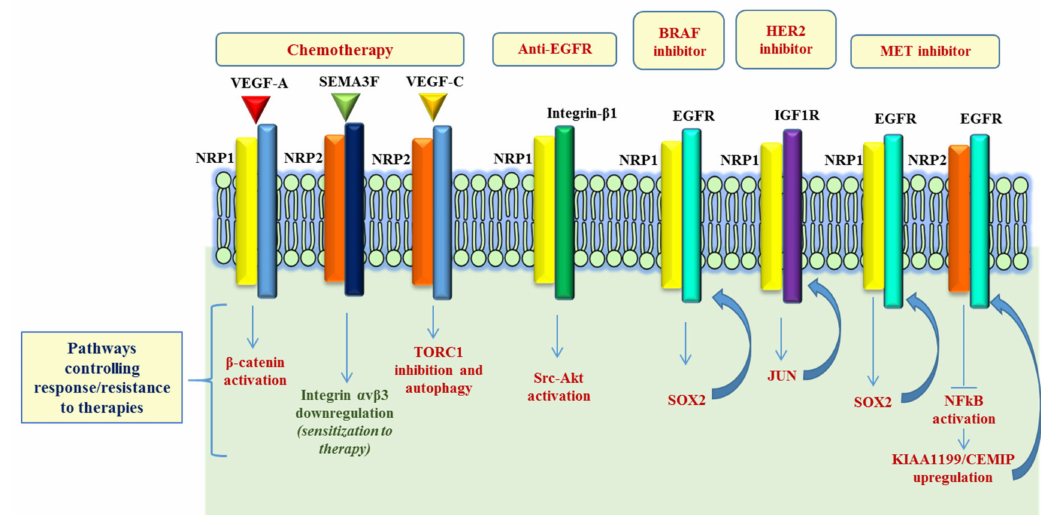
Figure 2. NRP-dependent pathways involved in resistance to therapy. Schematic representation of the signaling pathways regulated by NRPs in response to chemotherapy and controlling responsiveness / resistance to oncogene-targeted therapies. While in most cases, NRPs expression mediates drug resistance, in two studies it was shown that NRP2 negatively controls mechanisms supporting cancer cell viability (e.g., Integrin α v β 3 and KIAA1199) in response to therapy. Refer to main text for details and